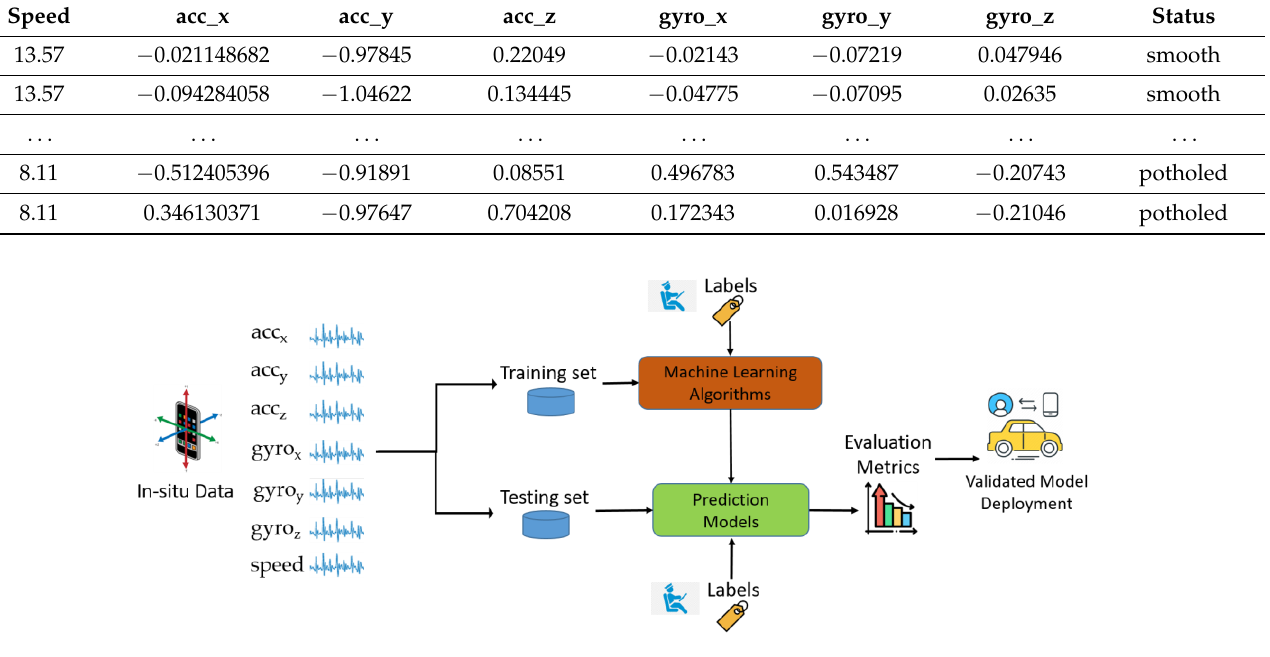
Figure 7. The general structure of an Artificial Neural Network (ANN) [25]. 5.2.2. Support Vector Machines The SVM (Support Vector Machine) [26] is a supervised ML technique that is largely employed for classification. This approach is founded on two fundamental ideas. The first premise is the maximization of the hyperplane ’ s margin. The objective is to identify the best hyperplane that divides classes by the largest margin. In the case where data are sep- arable in a linear manner, this is a typical quadratic-type optimization issue. Nonetheless,